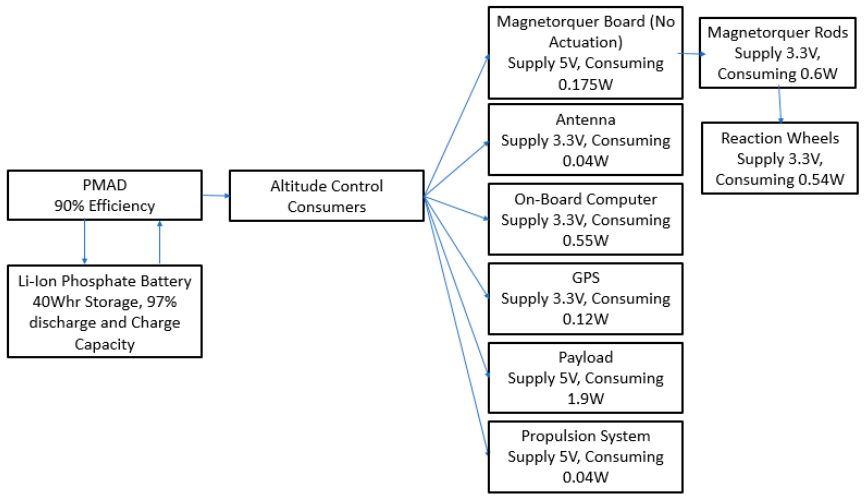
Figure 43. Cold Case Altitude Control Block Diagram.